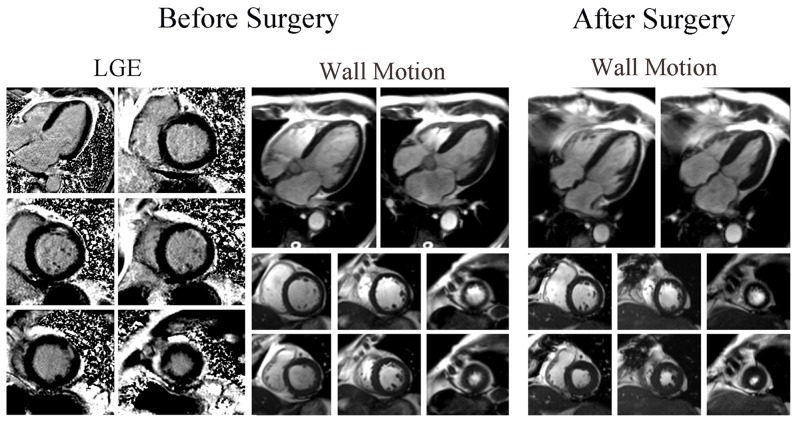
Patient with Global Functional Recovery.LGE and wall motion images before and after CABG of a 69-year-old man with 2 scar segments who had improvement in both global function and LV geometry.